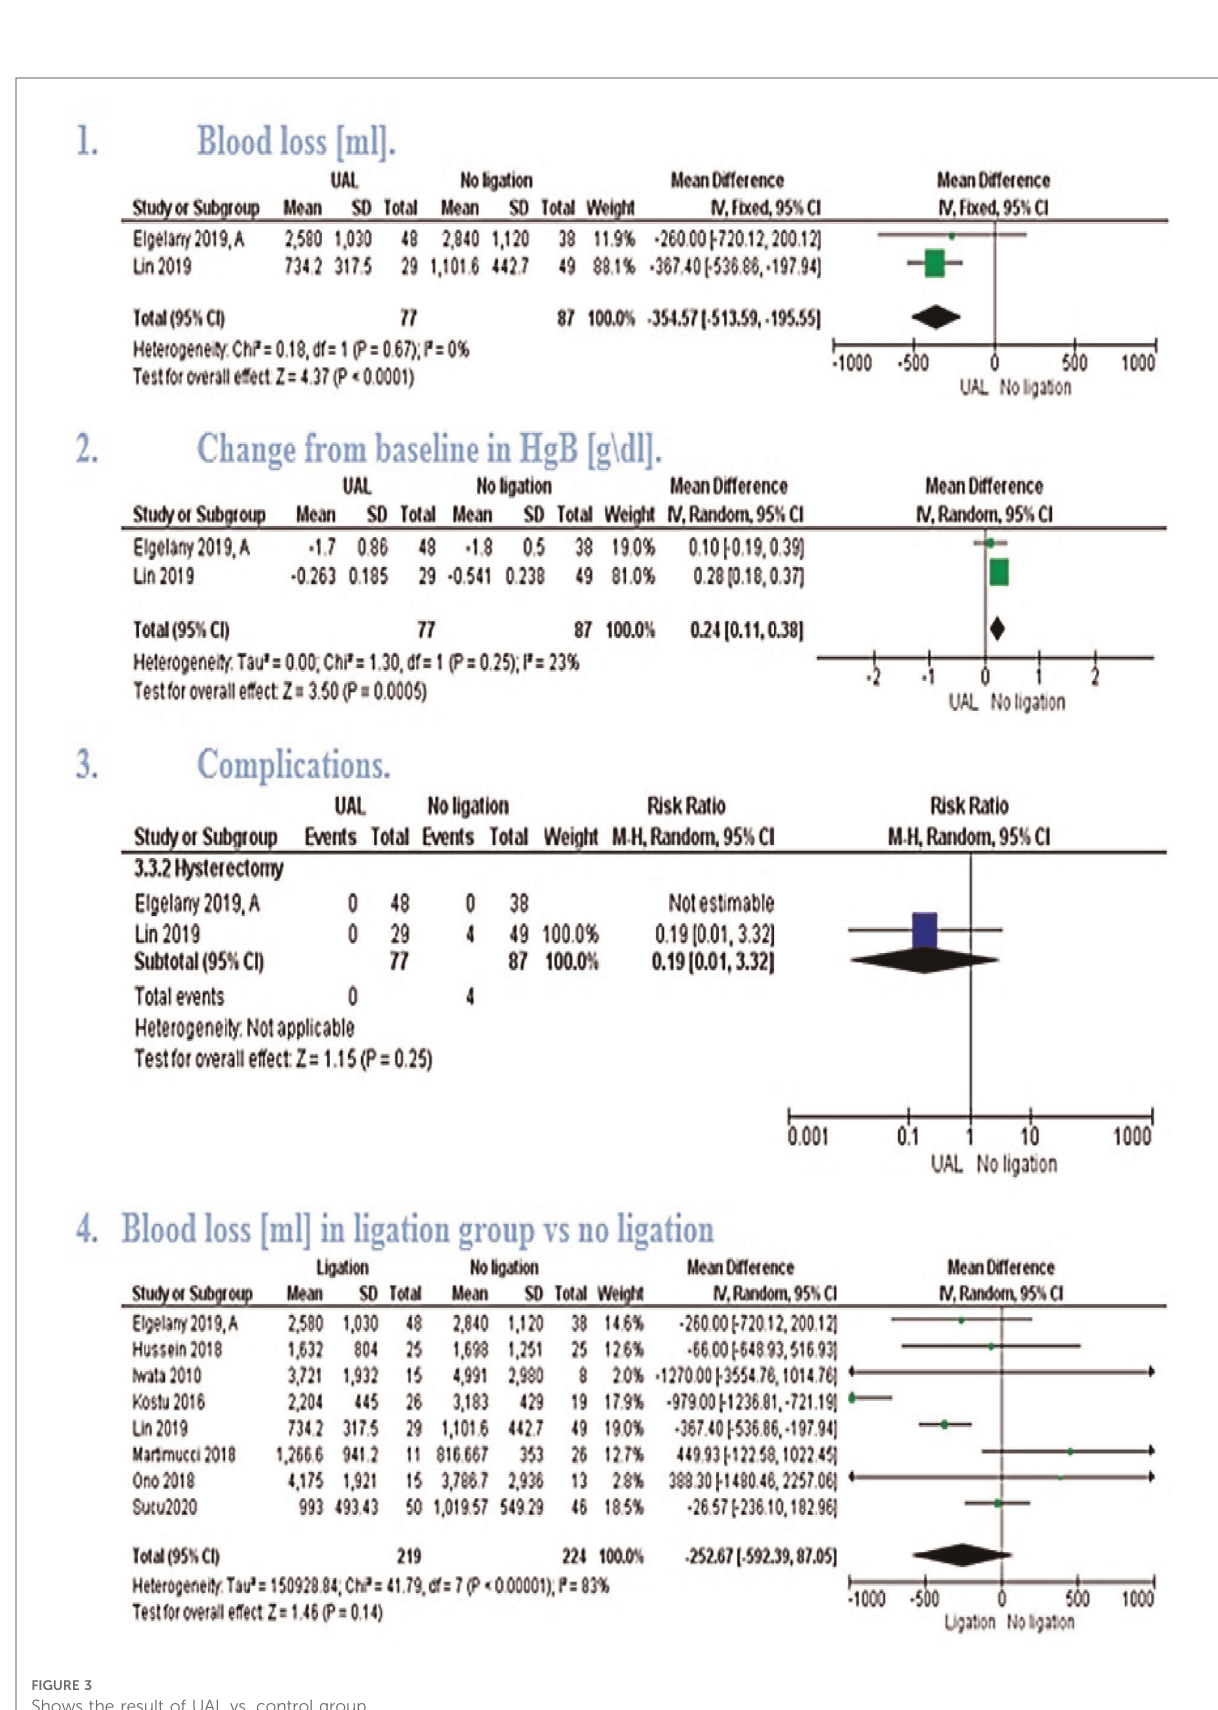
FIGURE 3 Shows the result of UAL vs. control